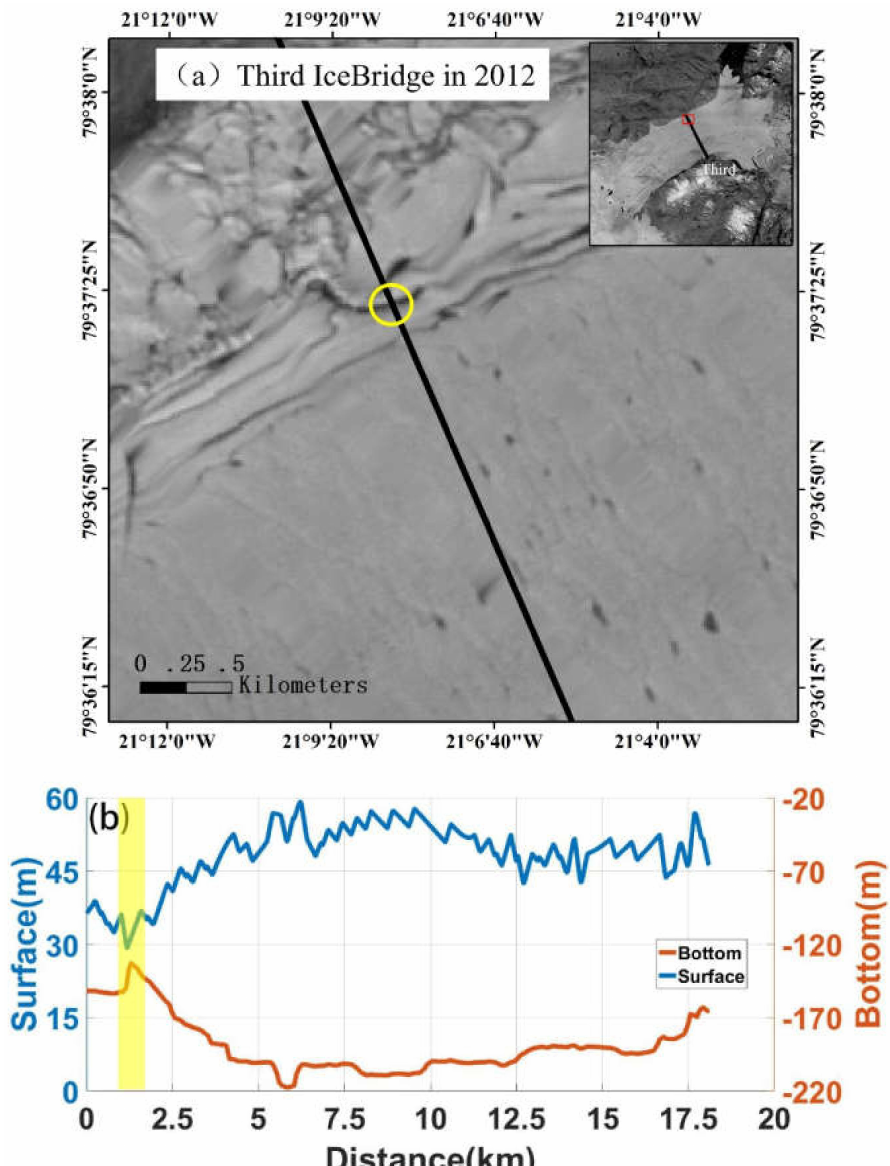
Figure A2. The third IceBridge in 2012 validates the data and Landsat imagery. ( a ) shows the surface morphology at the third IceBridge data in 2012, with IceBridge airborne radar flight path (black solid line). The location indicated by the yellow circle is the area confirming the existence of the basal channel. ( b ) shows the results from the third IceBridge in 2012. The yellow area corresponds to the yellow circle in ( a